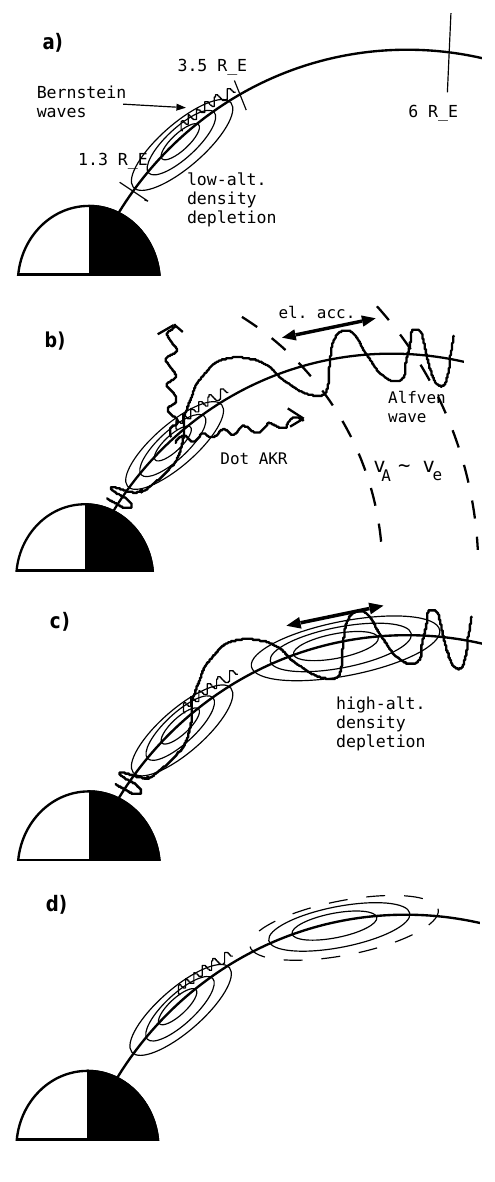
Fig. 12. Our view of processes that Alfv´en-wave activity causes on auroral field lines: (a) low-altitude auroral cavity associated with stable auroral arc and maintained by, for example, the coopera- tive model involving ion Bernstein waves (Olsson and Janhunen, 2004), (b) at substorm onset, Alfv´en waves arrive from the magne- tosphere, causing electron acceleration in the Alfv´en resonosphere (ARS) where v A ≈ v e and possibly also dot-AKR emission in the low-altitude cavity (the dot-AKR emission is usually short-lived and probably requires strong transient Alfv´en waves), (c) if Alfv´en wave activity lasts for some time, electron acceleration causes some ions to leave ARS as well, leading to an ARS cavity, (d) after the Alfv ´ en-wave activity has stopped, the ARS cavity fills up in the ion time scale, so that it continues to exist for some time (the low-altitude depletion is all the time maintained by other processes which are independent of Alfv´enic acvitity). Normal AKR is emit- ted all the time near the lower boundary of the cavity, although not